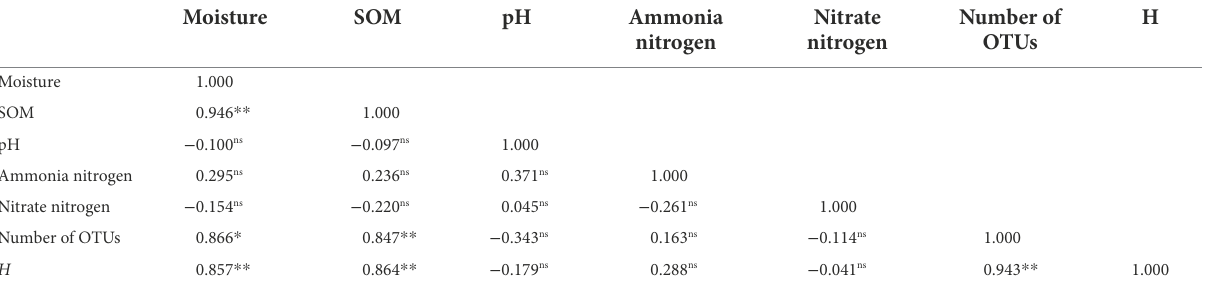
TABLE 2 Pearson’s correlation coefficients between the parameters of each site on March